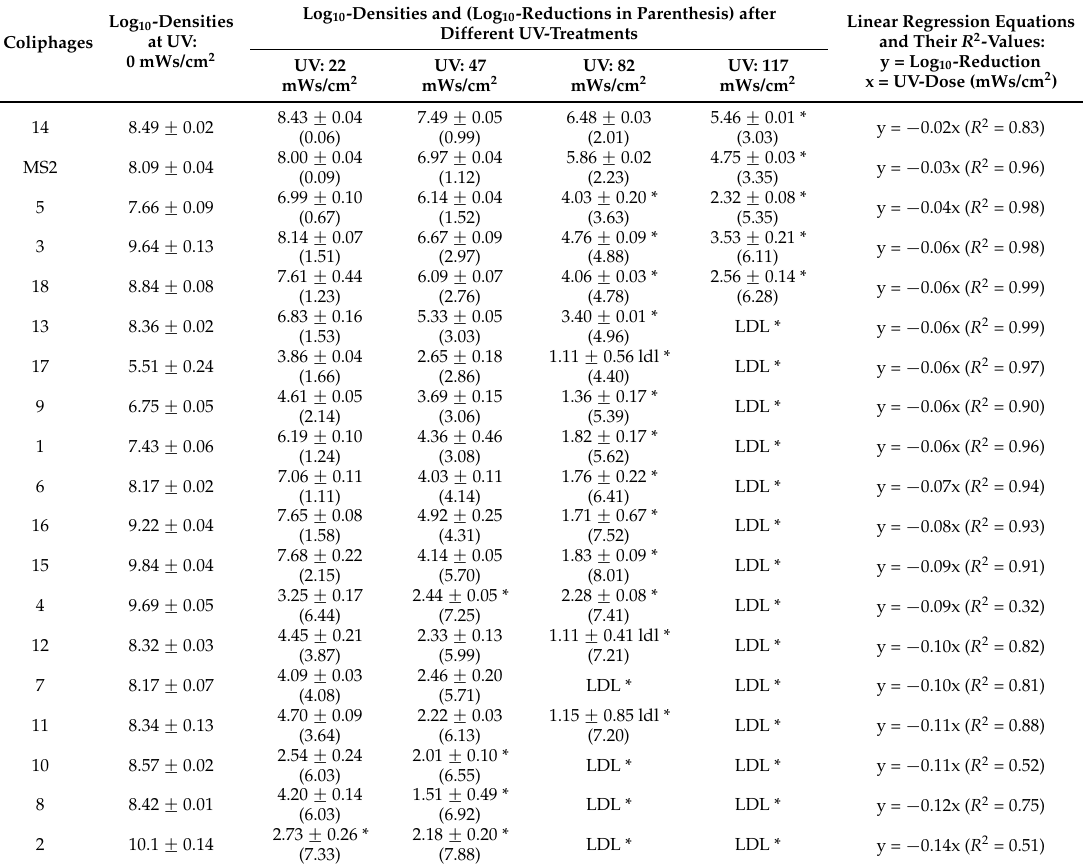
Table 1. Log 10 -densities (Mean ˘ SD, n = 3) and (Log 10 -reductions in parenthesis) of MS2 and the isolated 18 coliphages before and after different doses of UV (mWs/cm 2 ). Statistically significant differences from the control (UV dose 0 mWs/cm 2 ), assessed by related sample Friedman’s two-way analysis of variance, are indicated with asterisks, * p < 0.05. LDL = less than the detection limit (<10 PFU/mL) in all three parallels, ldl = less than the detection limit in one or two parallels. Log 10 -Densities and (Log 10 -Reductions in Parenthesis) after Log 10 -Densities Linear Regression Equations Different UV-Treatments at UV: and Their R 2 Coliphages 0 mWs/cm 2